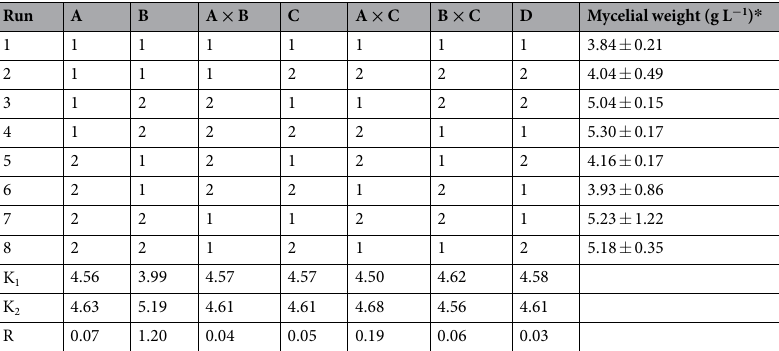
Table 11. L 8 (2 7 ) orthogonal experiment. A, B, C, D are D-( + )-glucose, beef extract, V B1 , and experimental error, respectively. A × B, A × C and B × C represent the interactions between the factors D-( + )-glucose and beef extract, D-( + )-glucose and V B1 , and beef extract and V B1 , respectively. * Values are the mean ± SE of triplicate determinations. K 1 and K 2 are the mean value of level 1 and level 2, respectively. R is the maximum of K 1 and K 2 minus the minimum of K 1 and K 2 , respectively.